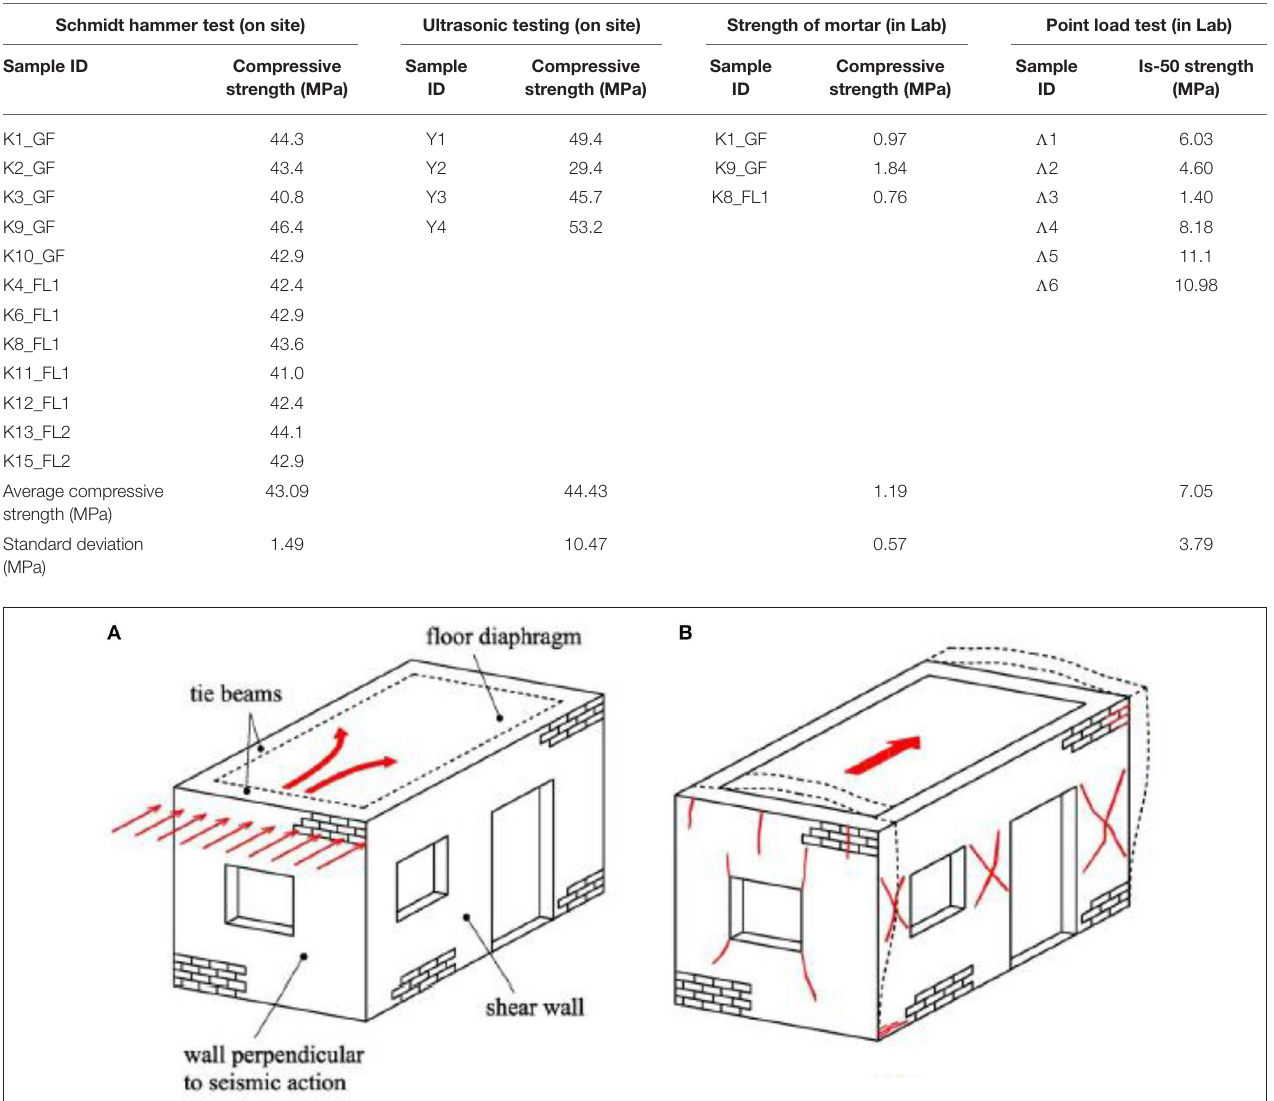
TABLE 1 | Material properties determined by the performed tests. Schmidt hammer test (on site)